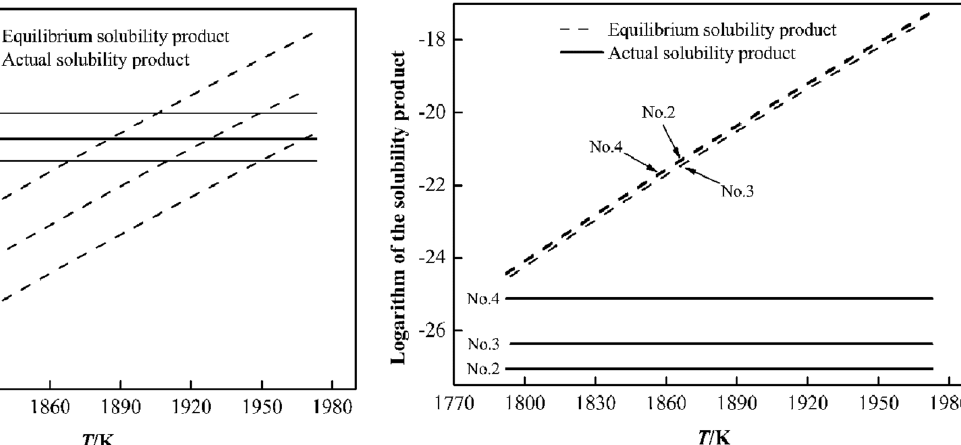
Figure 6: Logarithm of the solubility product as a function of temperature for Y 2 S 3 in the liquid